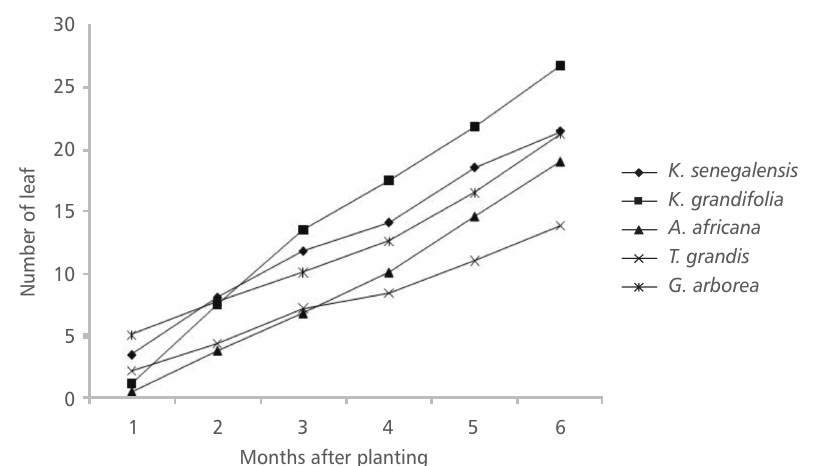
FIGURE 3. Number of leaf of the tree species after six